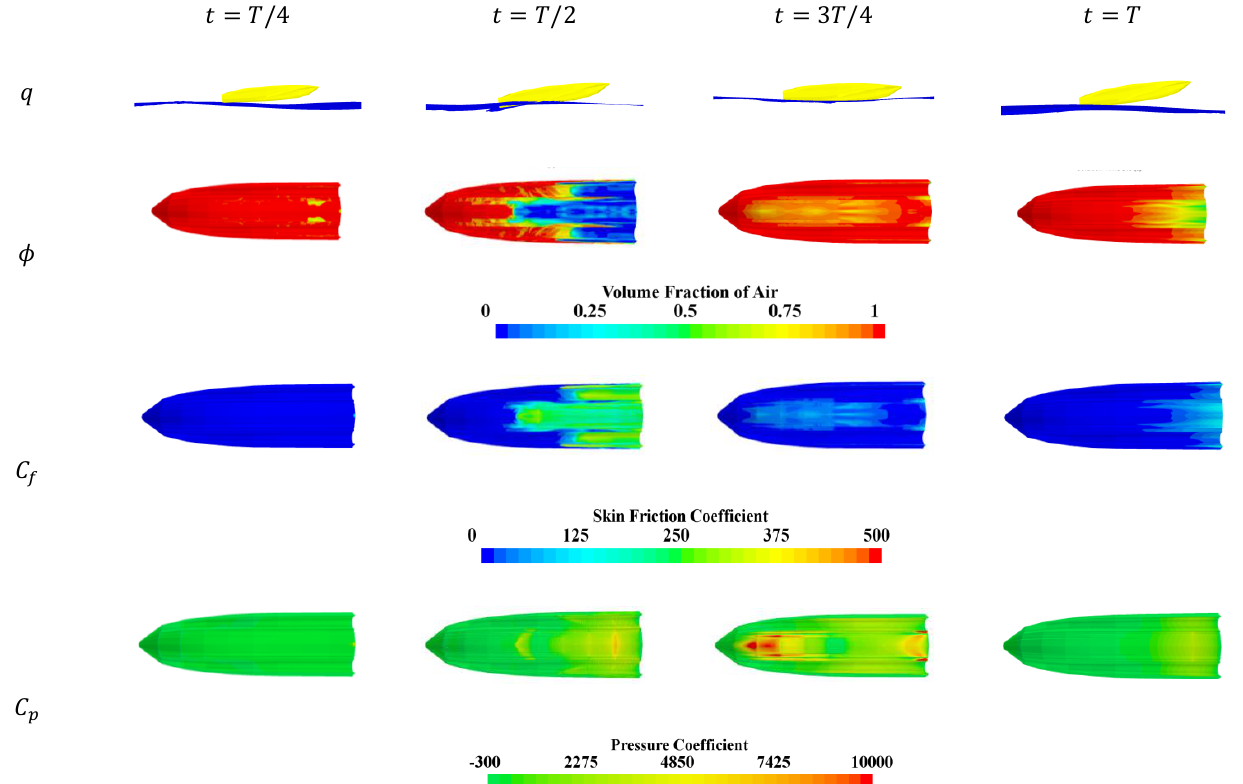
Figure 13. Snapshots of Model B motion during different stages. The first, second, third, and fourth rows, receptively, show the snapshots of the vessel’s position to the water surface, volume fraction over, skin friction coefficient, and the hydrodynamic pressure coefficient. The results correspond to the wavelengths of 2 L and a beam Froude number of 3.1.